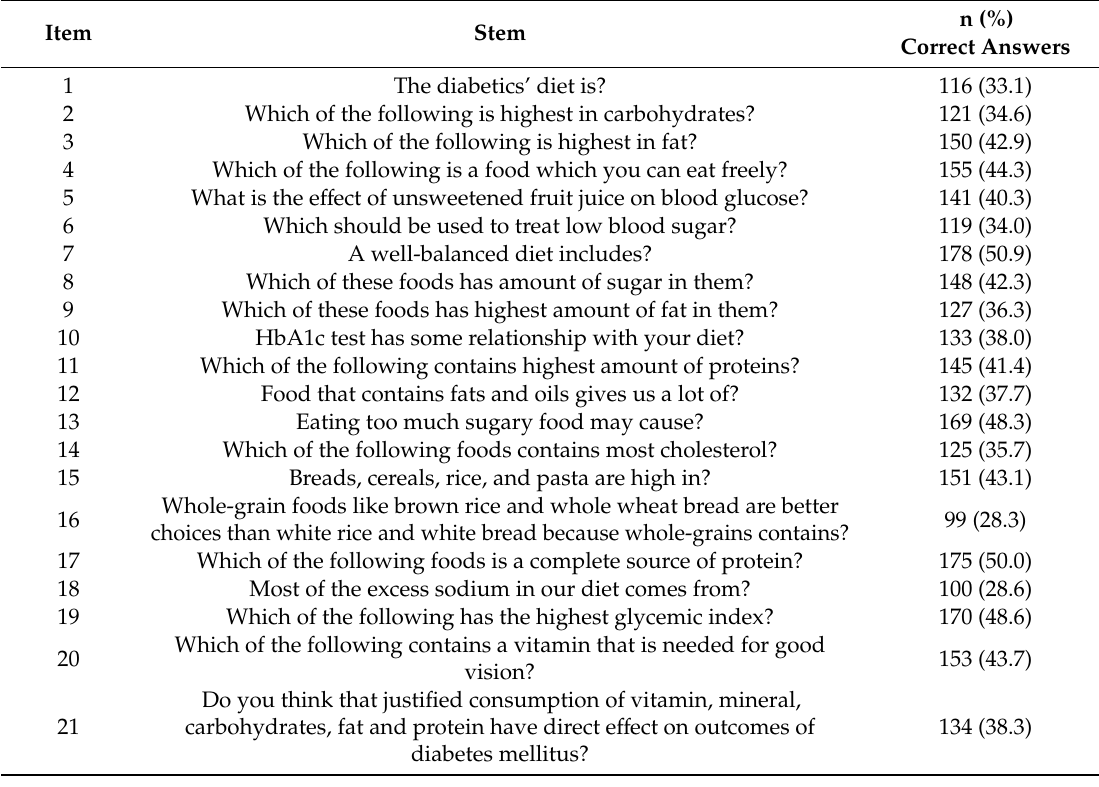
Table 2. Dietary knowledge of type 2 diabetics (n =